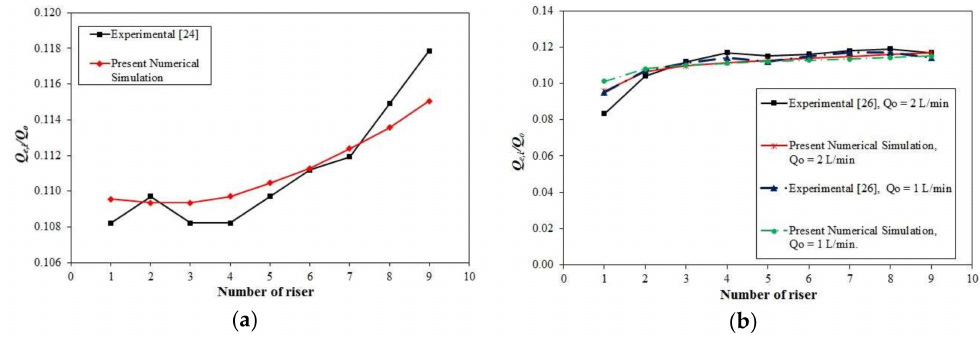
Figure 8. Comparison between numerical solution and experimental data in ( a ) laminar flow conditions, and ( b ) turbulent flow conditions.